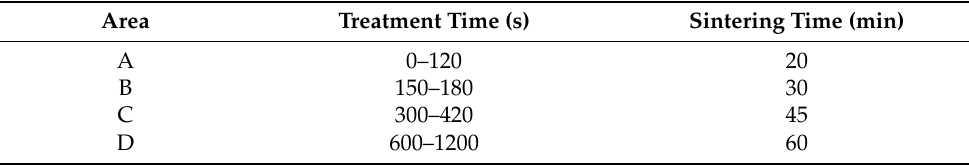
Table 1. Duration of plasma treatment and sintering